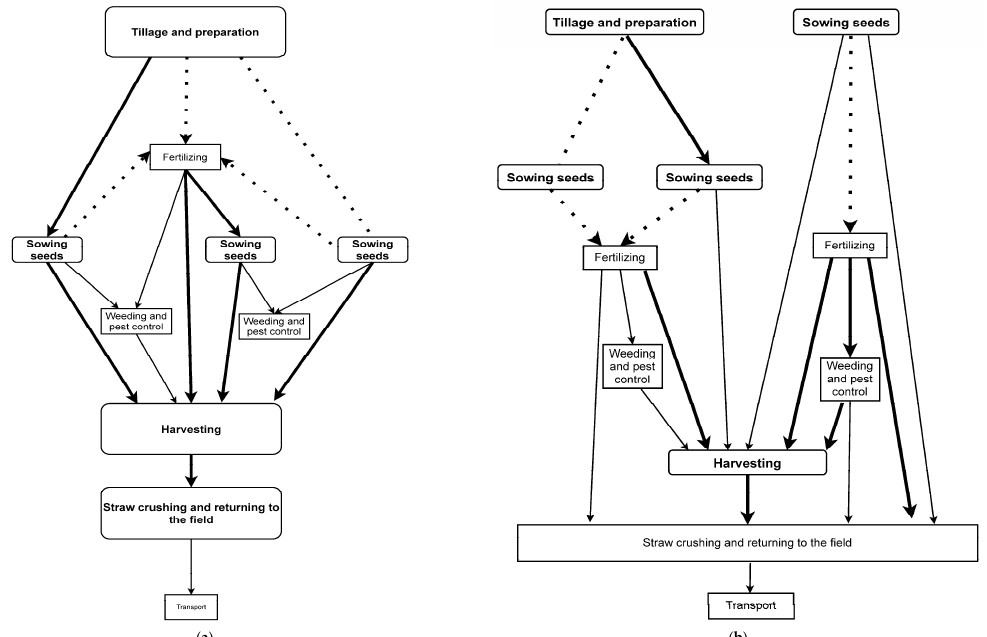
Figure 2. Wheat and maize planting operation flow. ( a ) Wheat planting operation flow; ( b ) Maize planting operation flow